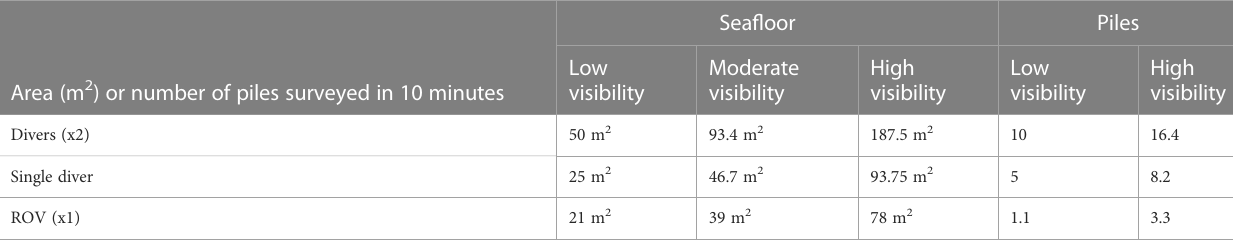
Area or number of piles also separated by water visibility at the time of inspection, low visibility (0.8 m secchi), moderate visibility (1.5 m secchi), and high visibility (3 m